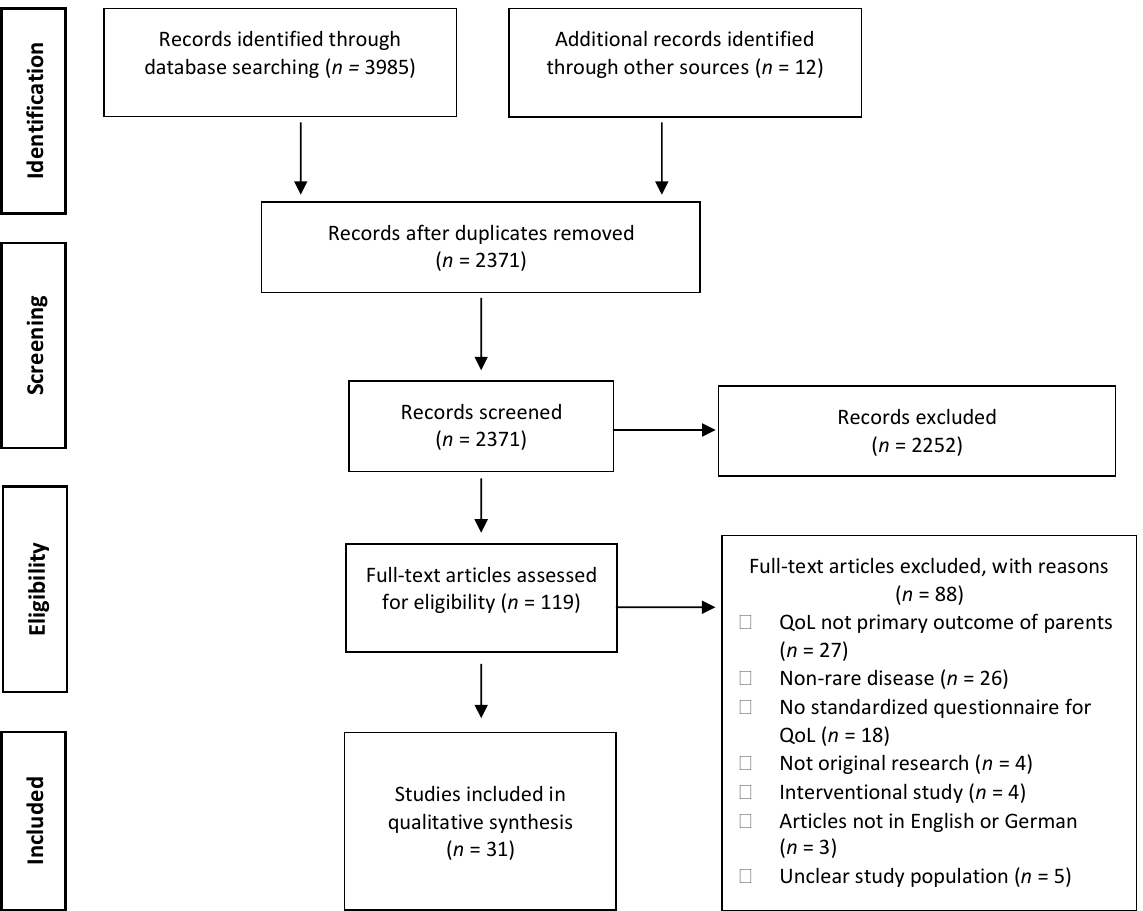
Figure 1. PRISMA flow diagram for the literature search and selection process. Source: Own elaboration based on the data obtained in the study. Table 2. List of rare diseases by clinical category.